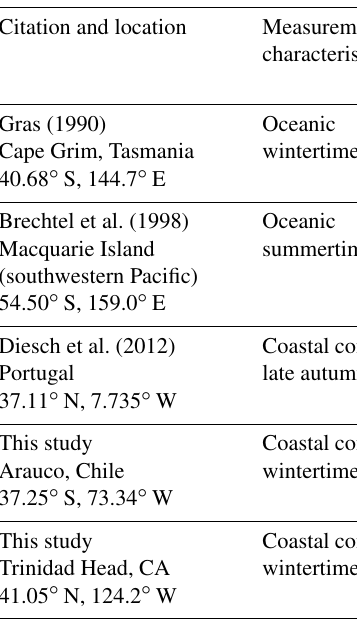
Table 2. Classification of air mass type.